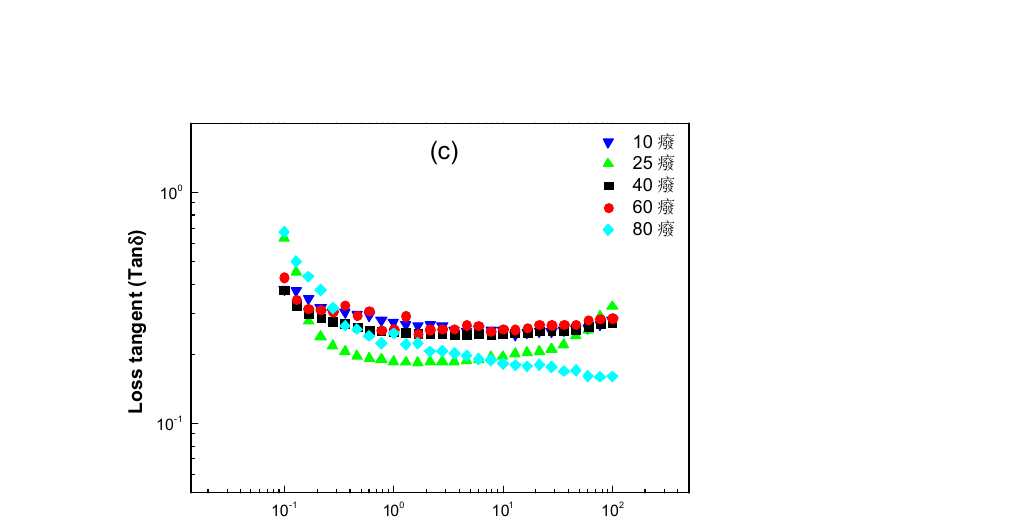
Table 4. The viscoelastic properties of hydrocolloids from Pereskia bleo leave in a frequency sweep at 1 Hz. Temperature